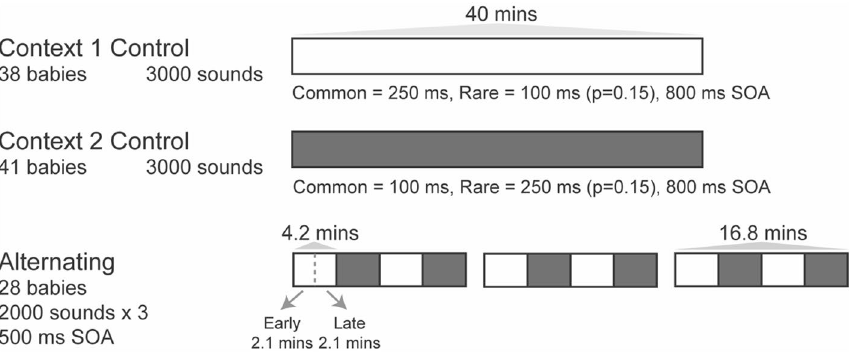
Figure 1. Depiction of the sound sequences used for the control and alternating experiments. The control context sequence was a single stream of sounds about 40 min in length. The alternating sequence contained four × 4.2 min blocks of 500 sounds (16.8 min total length) and it was presented three times with breaks between. For data analysis, the alternating sequence data was further divided to capture early and late periods of time within the two context blocks with indicative periods marked in the